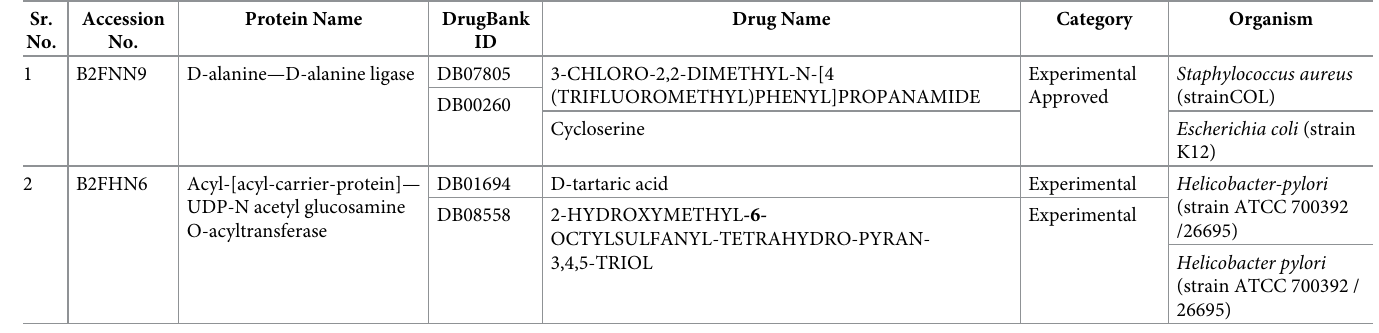
Table 3. Drug-able target proteins analysed via DrugBank. Sr.